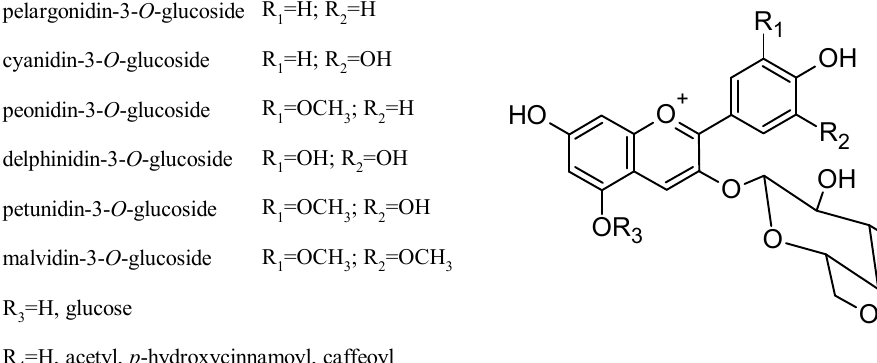
Table 1. Oligomeric anthocyanins identified by liquid chromatography-mass spectrometry (LC/MS) analysis in Shiraz grape skins. F, fragment